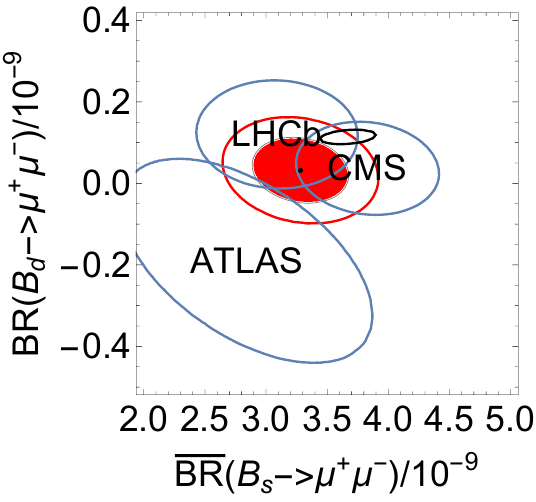
Figure 4 . Combination of joint measurements of BR ( B s → µ + µ − ) and BR ( B d → µ + µ − ) . The blue ellipses show the 68 % CL ellipse from each individual experiment (labelled in the centre of each ellipse, respectively), whereas the filled red ellipse shows their combination. The empty red ellipse shows the 95 % CL contour of the combination. The 68 % CL SM prediction with flavio2.3.3 defaults is shown as the small black